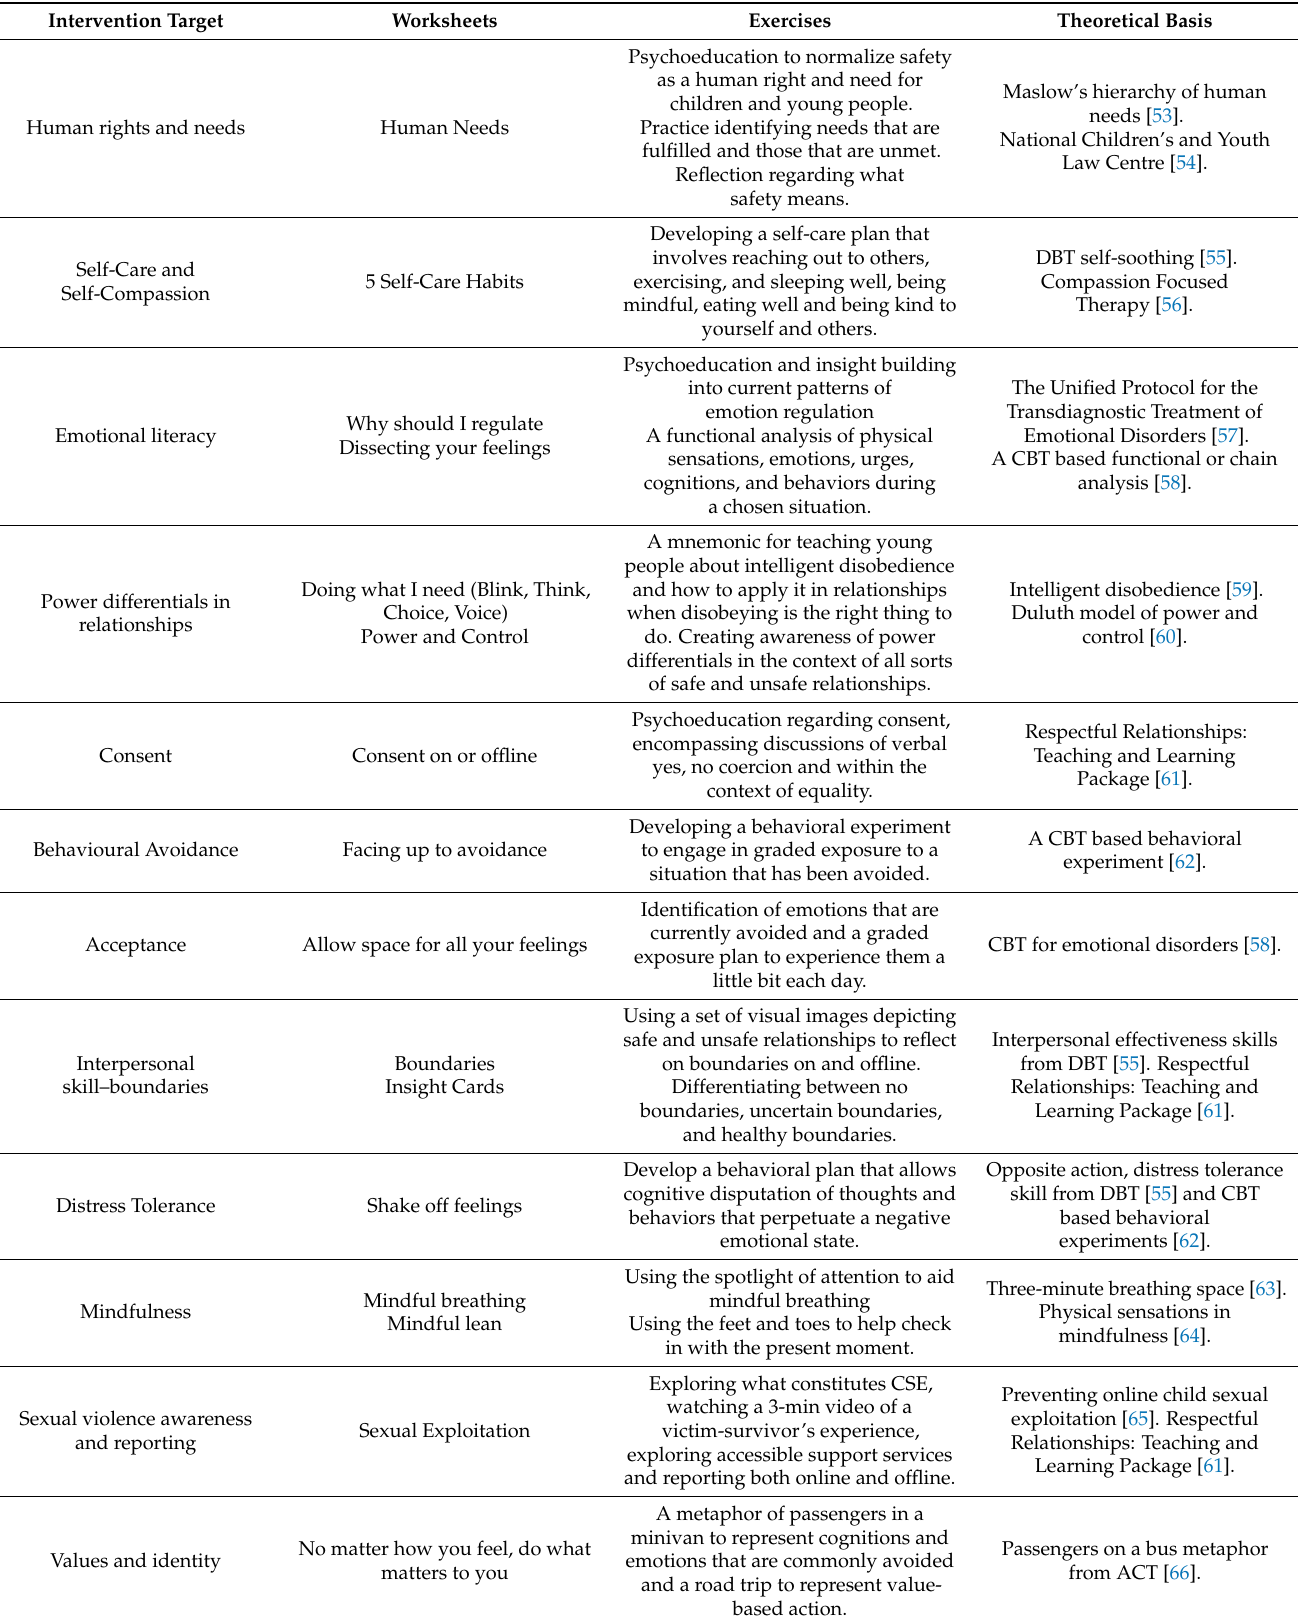
Table 2. ERIC + YR Domains and Exercises Delivered During Intervention